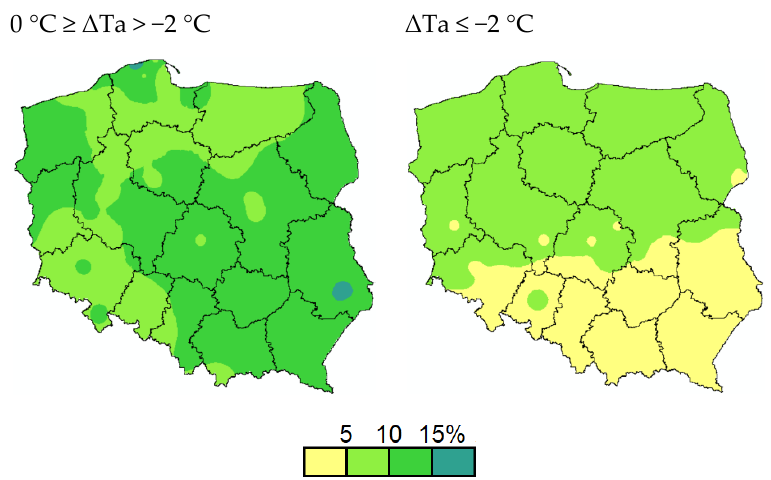
Figure 13. Frequency of spring (from March to May) precipitation deficits in Poland, depending on air temperature, expressed as deviation from the area multi-year mean ( ∆ Ta). Years 1951–2018.